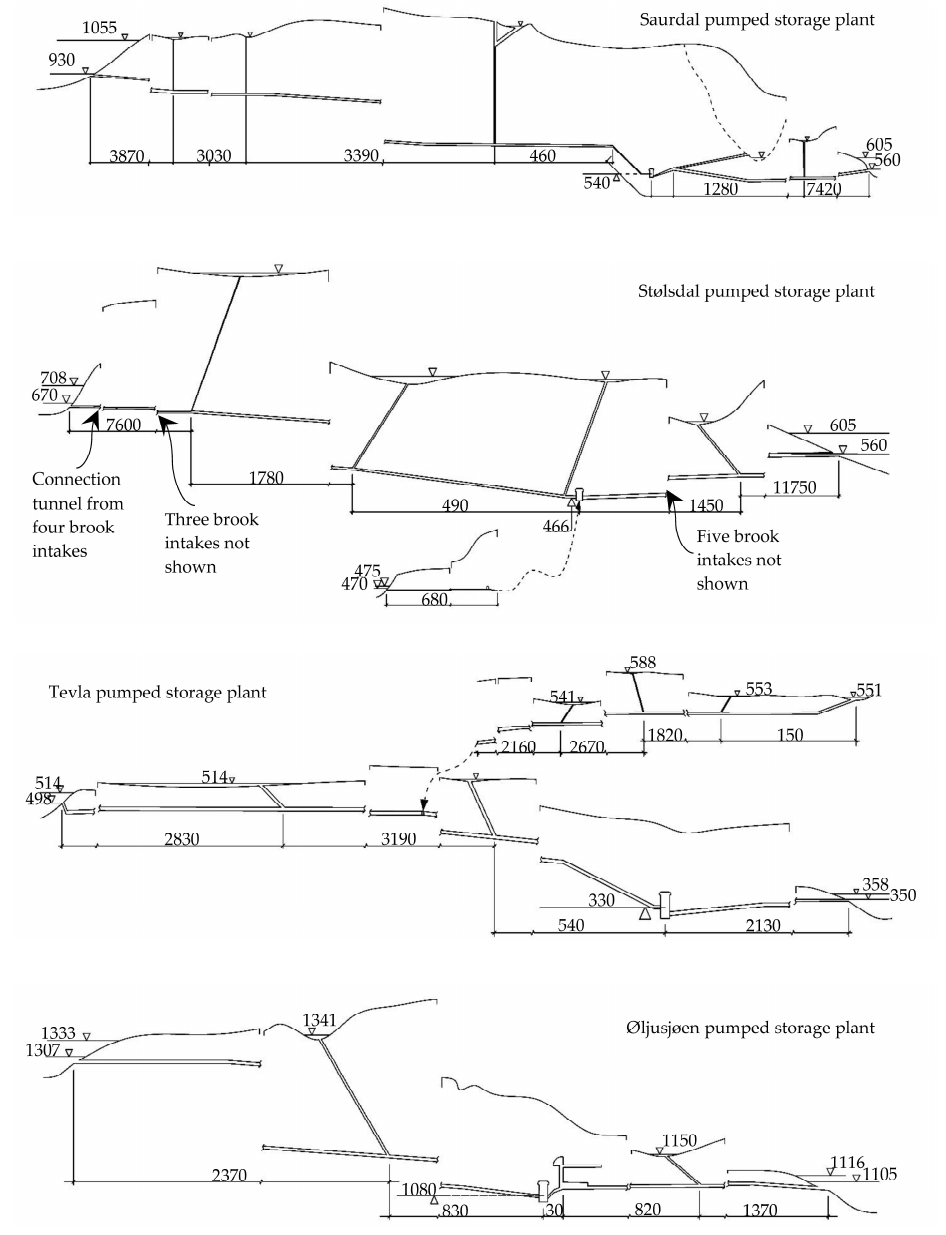
Figure 6. The tunnel system layouts of the pumped storage plants in